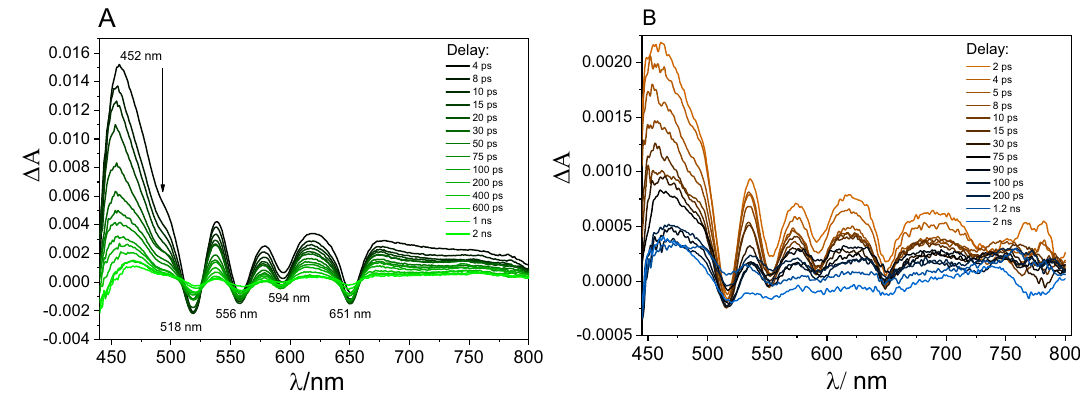
Figure 9. Transient absorption spectra registered at various time delays for: ( A ) TPPNH 2 and ( B ) GO-CONHTPP in DMF-H 2 O (1:2, v/v) following the 422 nm laser excitation.